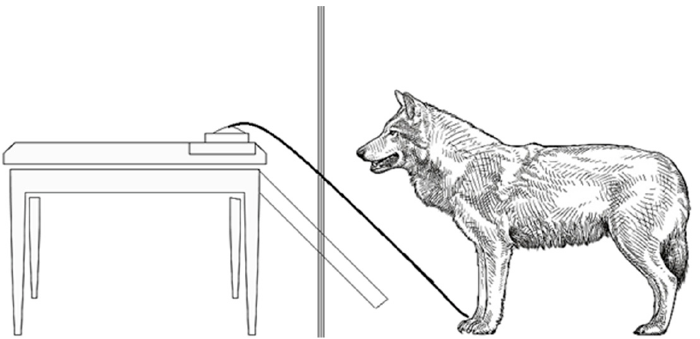
Figure 1. Exemplary presentation of the novel object and the described experimental set-up, adapted from Stefan_Alphonso. Stock Illustration ID:1397963840. from Stefan_Alphonso. Stock Illustration